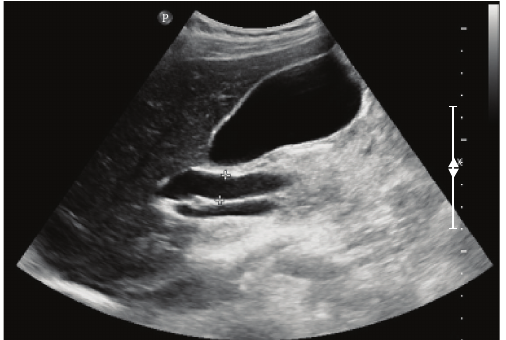
Figure 1: Abdominal ultrasound showing a dilated common bile duct (11mm).